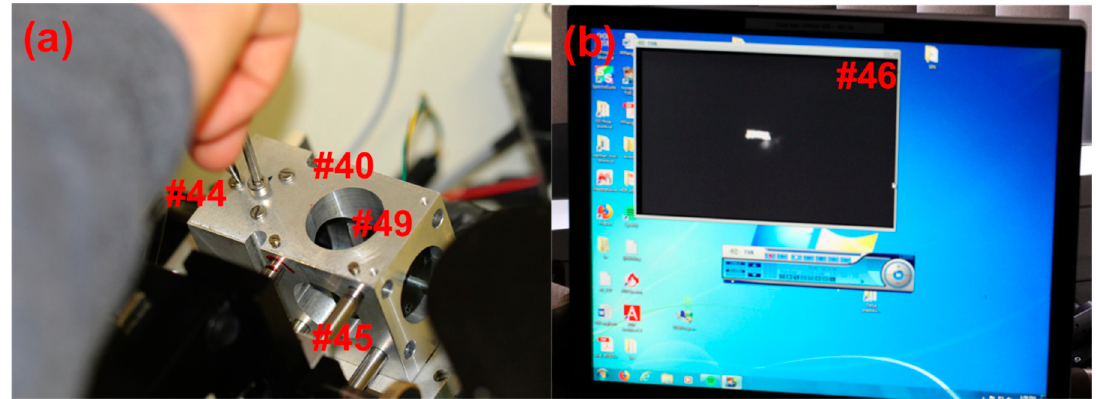
Figure 7. ( a ) Adjustments of the second imaging OAPM made by simultaneously tightening the center screw and loosening one of the three outer screws. In this way, the beam trajectory may be aligned onto the detection window. ( b ) The Sony XC-EI30 CCD video camera shows the image of the illumination slit. Beam alignment by adjusting the second imaging OAPM screws while viewing the slit image position through the CCD video capture.